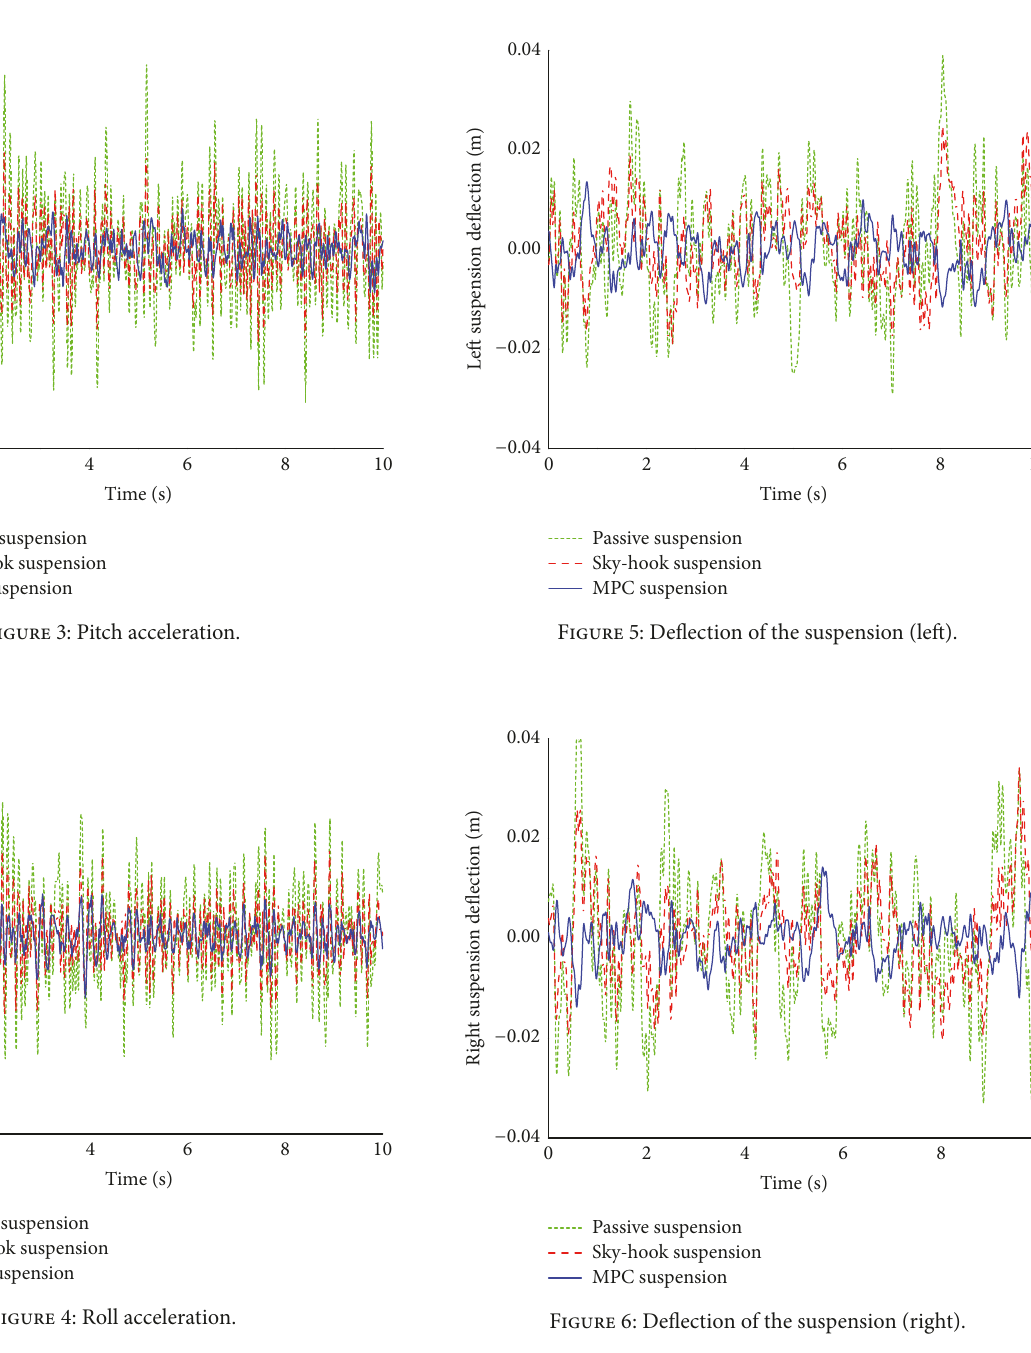
Figure 4: Roll acceleration.